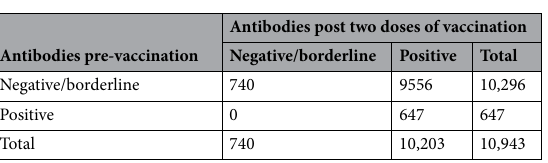
Table 3. Seroconversion (Pre and post antibody). * p value <